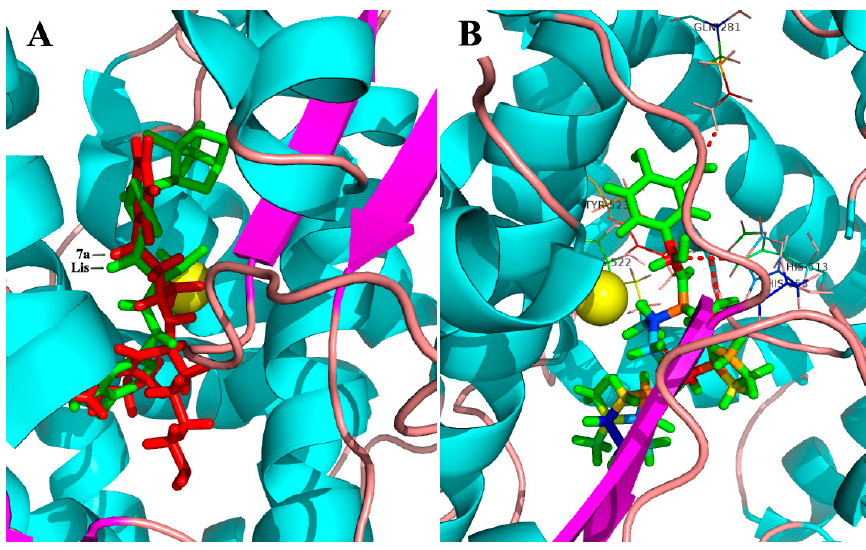
Figure 3 . ( A ) Docking confirmation of compound 7a (green) and ligand compound lisinopril with tACE; 1, α -helix; 2, random coil; 3, β -sheet; ( B ) Best expected binding mode of compound 7a (green) at the tACE binding site.